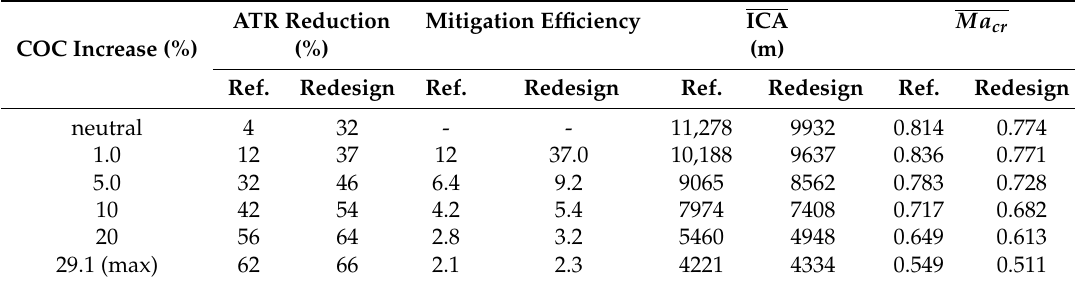
Table 7. Climate impact mitigation potentials and efficiencies for the reference (Ref.) and redesigned aircraft expressed relative to the reference scenario. Related fleet average ICA and Ma cr combinations are derived from the frequency distribution resulting at the given COC